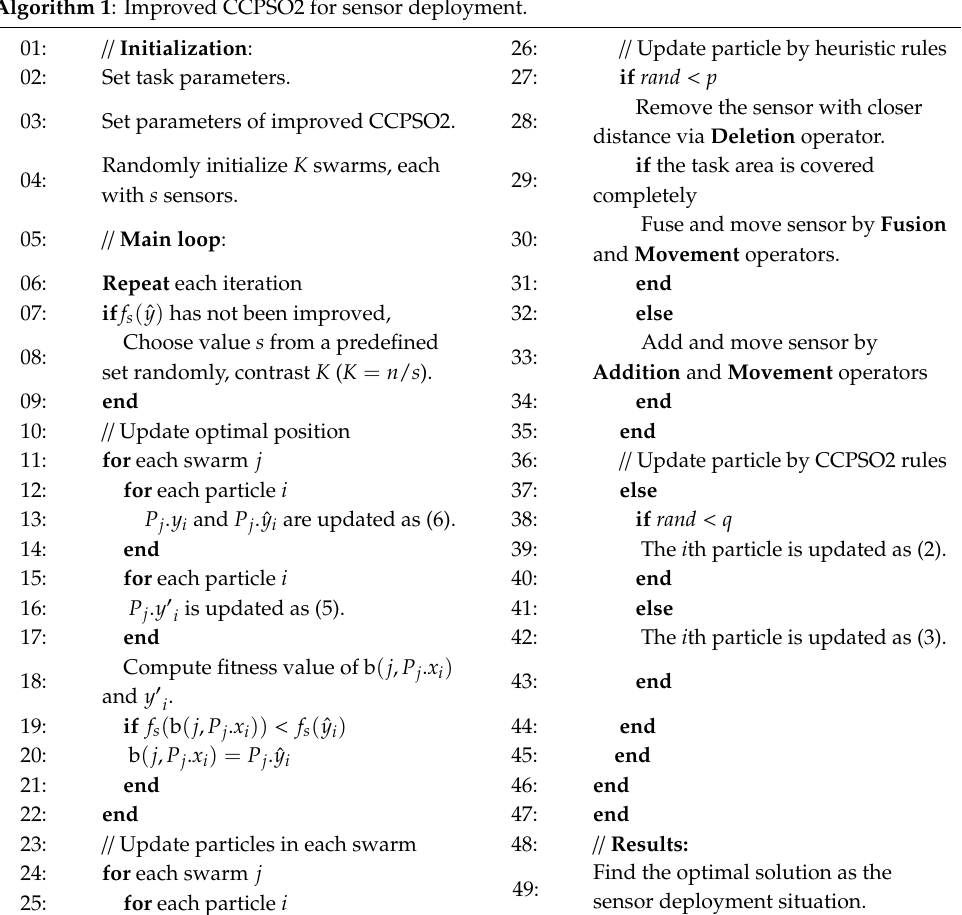
Algorithm 1. Pseudo-code of improved cooperatively coevolving particle swarm optimization (CCPSO2) for sensor deployment. Algorithm 1 : Improved CCPSO2 for sensor